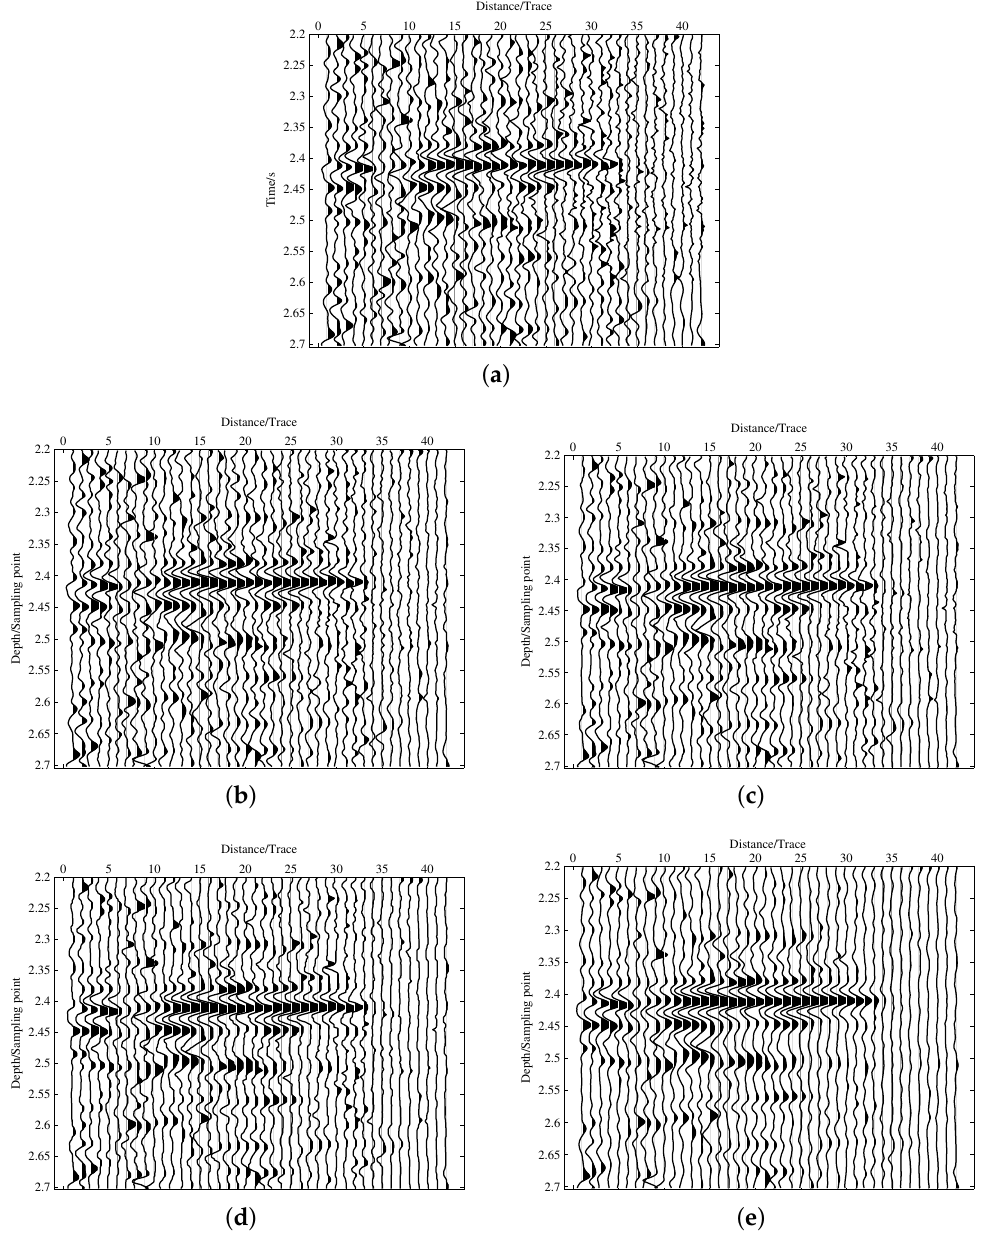
Figure 8. Field seismic data and its denoising results. ( a ) Field seismic data, ( b ) wavelet denoising result, ( c ) ITVD result, ( d ) ATVD result and ( e ) denoising result of the SD-SpaLR